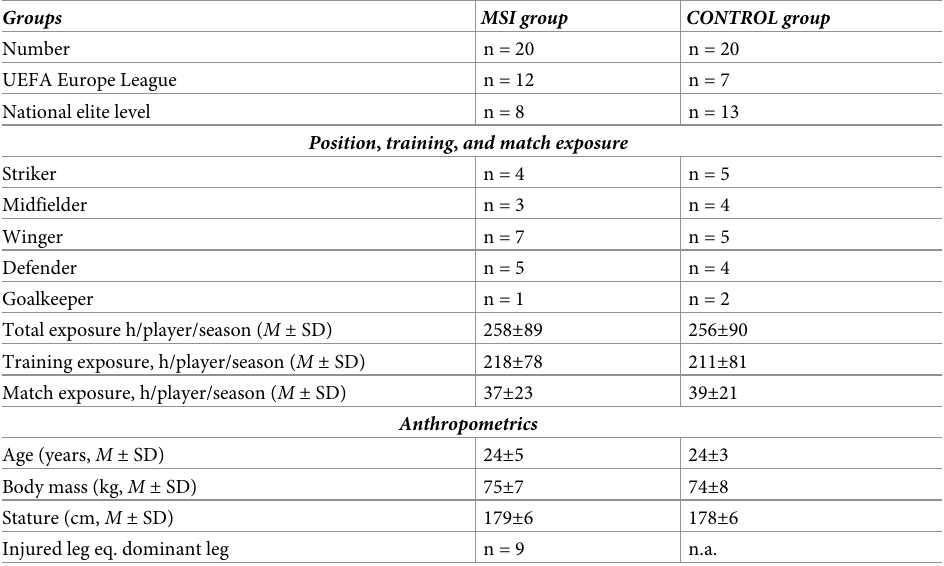
Table 1. Cohort characteristics, anthropometric data, and athletic specification.